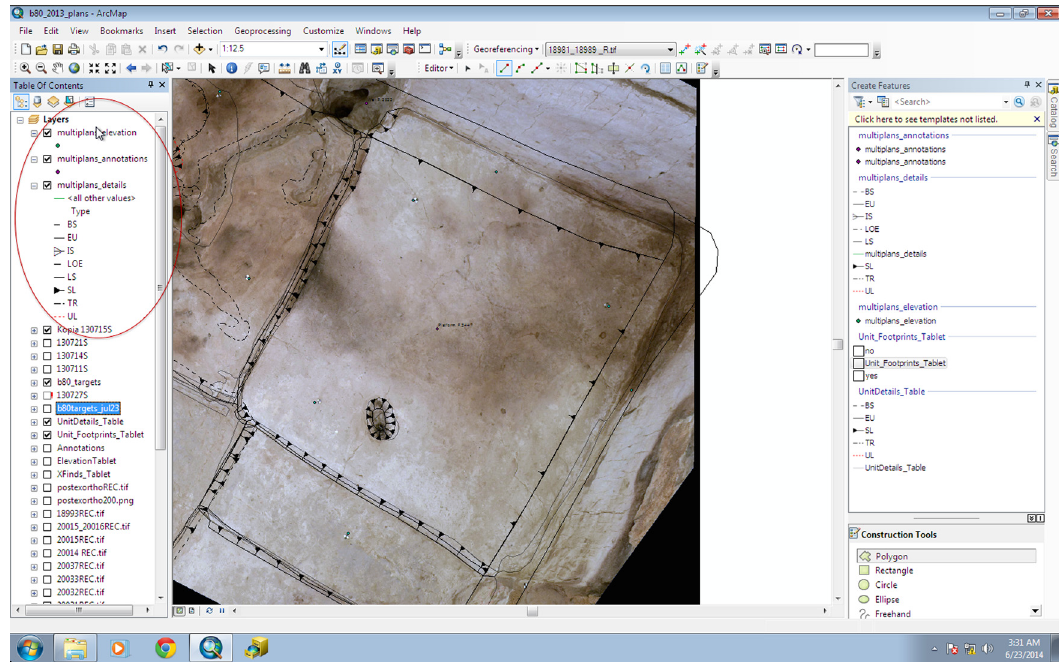
Figure 4: An example of a “ digital simulacrum ” from Çatalhöyük; a “ fl attened ” 2D orthophoto is exported from a 3D